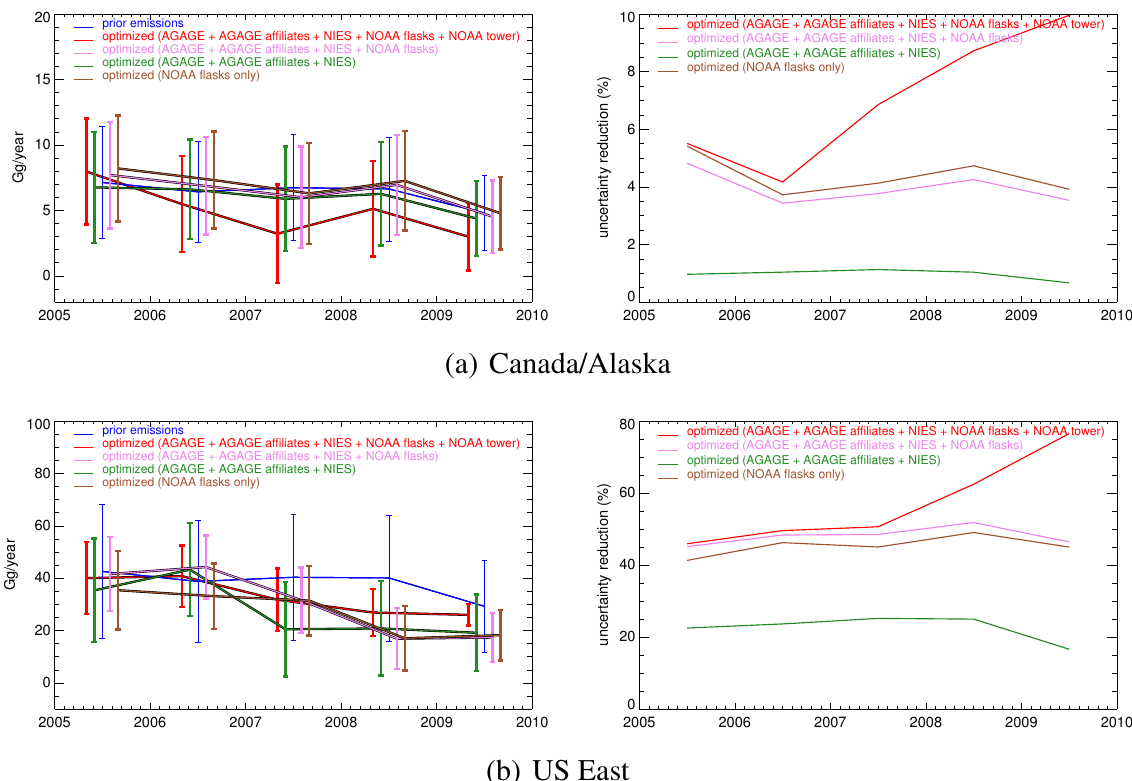
Fig. 6. Comparison of prior (blue) and optimized emissions using different sets of available observations (red: all measurements; pink: excluding NOAA tower; green: excluding all NOAA measurements; and brown: only NOAA weekly flask measurements) with respective uncertainty (left) and uncertainty reduction (right) in (a) Canada/Alaska, (b) US East, (c) US Midwest, (d) US West, (e) Central and South America, (f) Europe, (g) Africa/Middle East, (h) North Asia, (i) Article 5 Asia, and (j) Oceania for prior emissions (left figure only) and 4 inversion results.